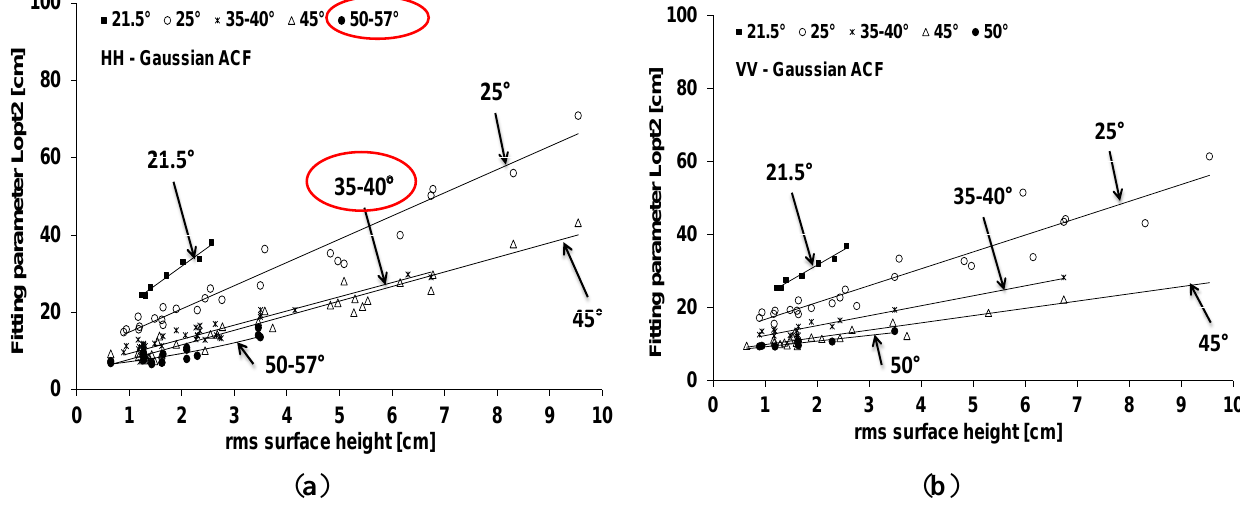
Figure 5. Fitting parameter Lopt2 as a function rms surface height with the Gaussian ACF.